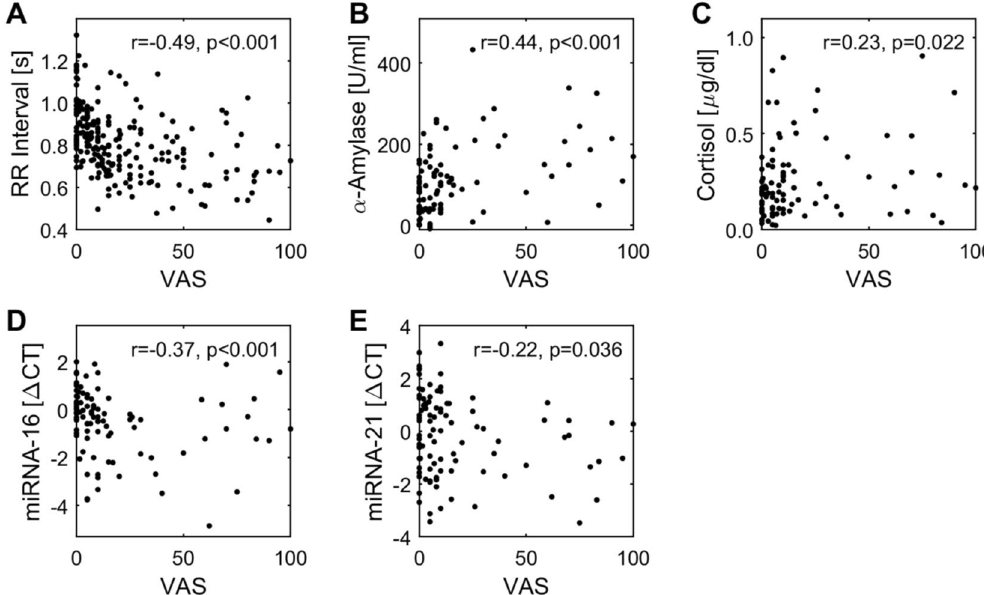
Figure 3. Correlations between VAS and other parameters. All correlations were calculated using Spearman rank correlation procedure. p < 0.05 as considered significant, p < 0.10 was considered showing tendency towards significance.